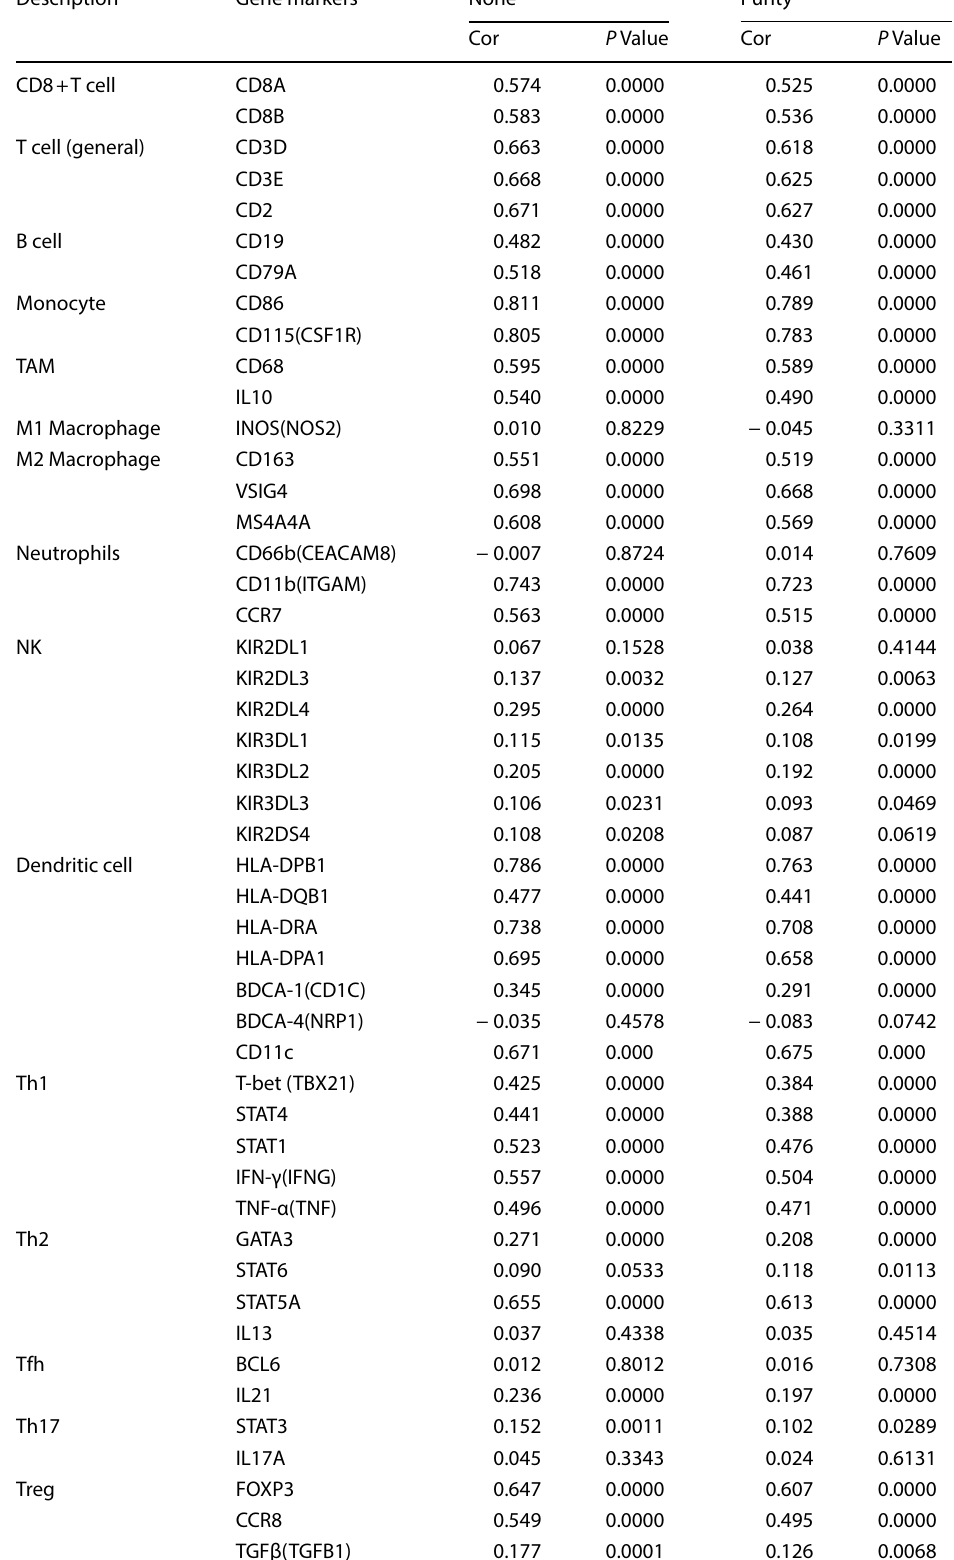
Table 3 The correlations between SPI1 and gene markers of immune cells in patients with